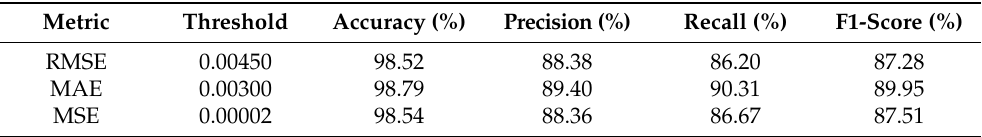
Figure 10. Reconstruction loss distribution. ( a ) Reconstruction loss distribution based on MAE; ( b ) reconstruction loss distribution based on MSE; ( c ) reconstruction loss distribution based on RMSE. As seen in Table 5, based on the three loss functions used, we obtained different thresholds. In spite of this, there are few differences between the evaluation results of the three loss functions. Among them, MAE provides the best detection results, while RMSE and MSE have essentially the same detection results. Table 5. Performance of different loss mechanisms.